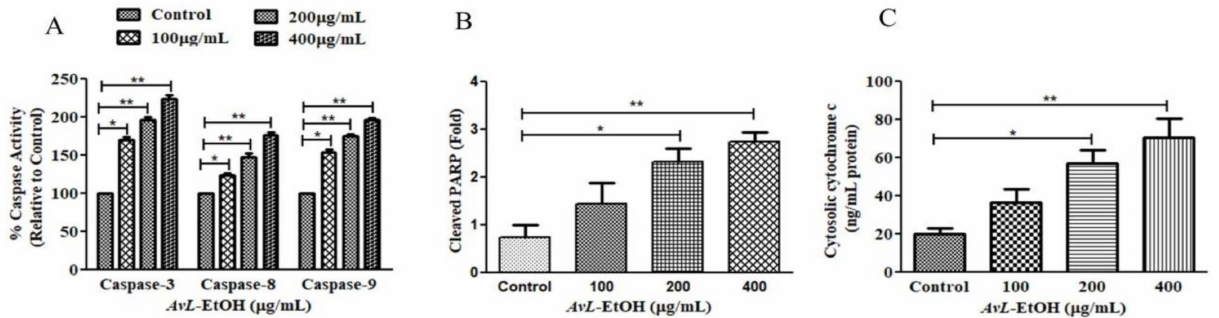
Figure 6. Efficacy of AvL -EtOH in modulating ( A ) the activities of different caspases, namely caspase- 3, -8 and -9, ( B ) the level of cleaved PARP and ( C ) cytosolic level of cytochrome-c within A549 cells exposed to varying concentrations of AvL -EtOH (100, 200 and 400 µ g/mL). * p < 0.05, ** p < 0.01. In addition, the real-time qPCR analysis revealed that AvL -EtOH (100, 200, and 400 µ g/mL) markedly increased the expression of proteins involved in apoptosis onset (Bax and Bad) by 1.47 ± 0.15-, 2.24 ± 0.05-, and 2.53 ± 0.05-fold and 1.34 ± 0.04-, 1.54 ± 0.03-, and 1.86 ± 0.05-fold, and decreased the expression of anti-apoptotic genes (Bcl-XL and Bcl-2) by 0.82 ± 0.02-, 0.73 ± 0.07-, and 0.52 ± 0.03-fold and 0.82 ± 0.06-, 0.68 ± 0.15-, and 0.47 ± 0.14-fold, respectively, in A549 cells (Figure